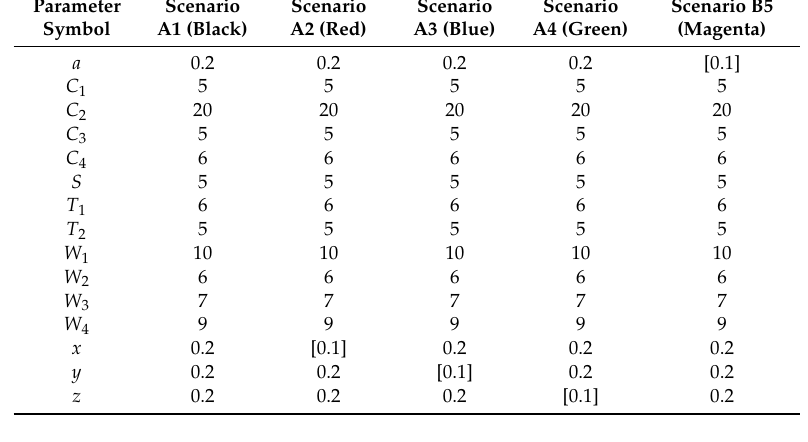
Table 7. Value of ideal scenario.